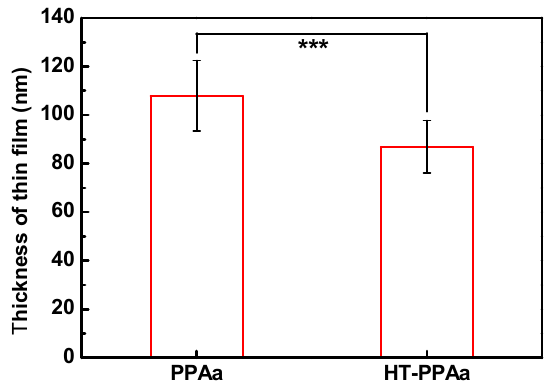
Figure 4. The thickness of PPAa and HT-PPAa film. Data are presented as mean ± SD ( n = 4) and analyzed using one-way ANOVA (* p < 0.05, ** p < 0.01, and *** p < 0.001).